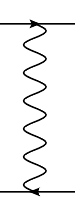
Figure 9: Electron-positron scattering in the high energy